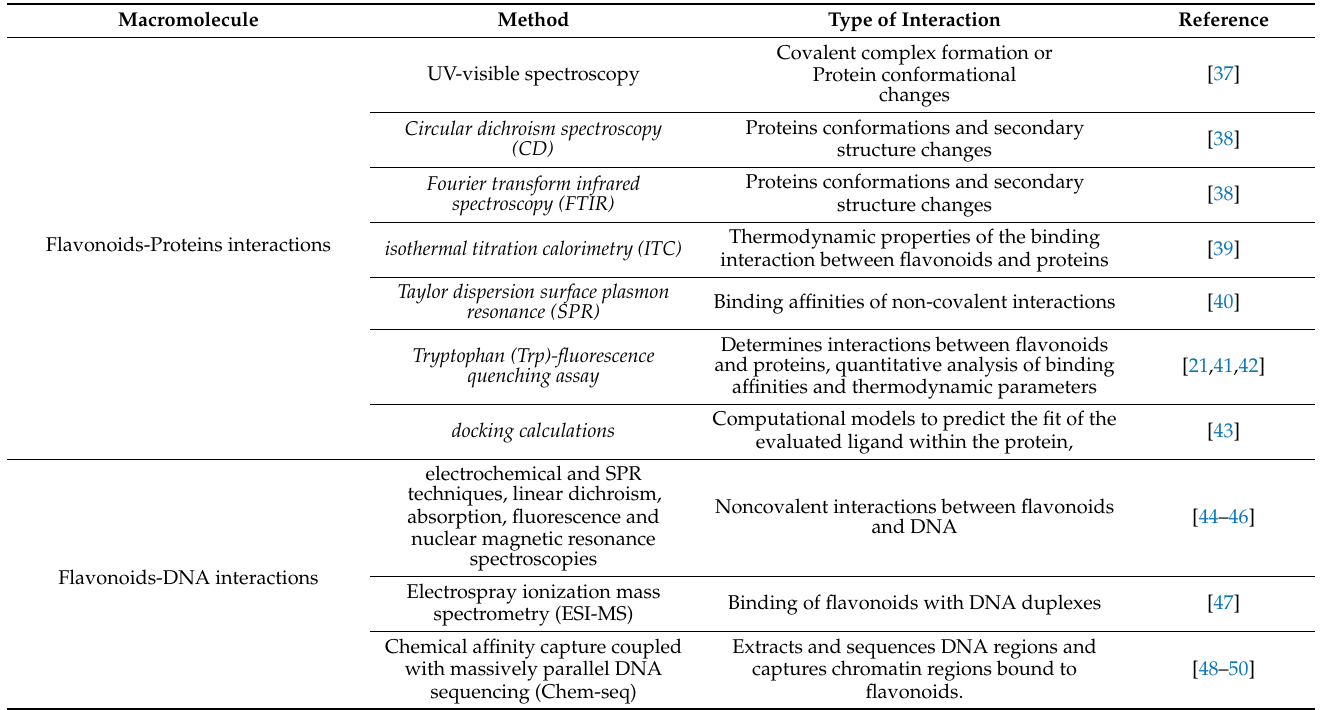
Table 1. Methods used to characterize flavonoids-macromolecules interactions. Macromolecule